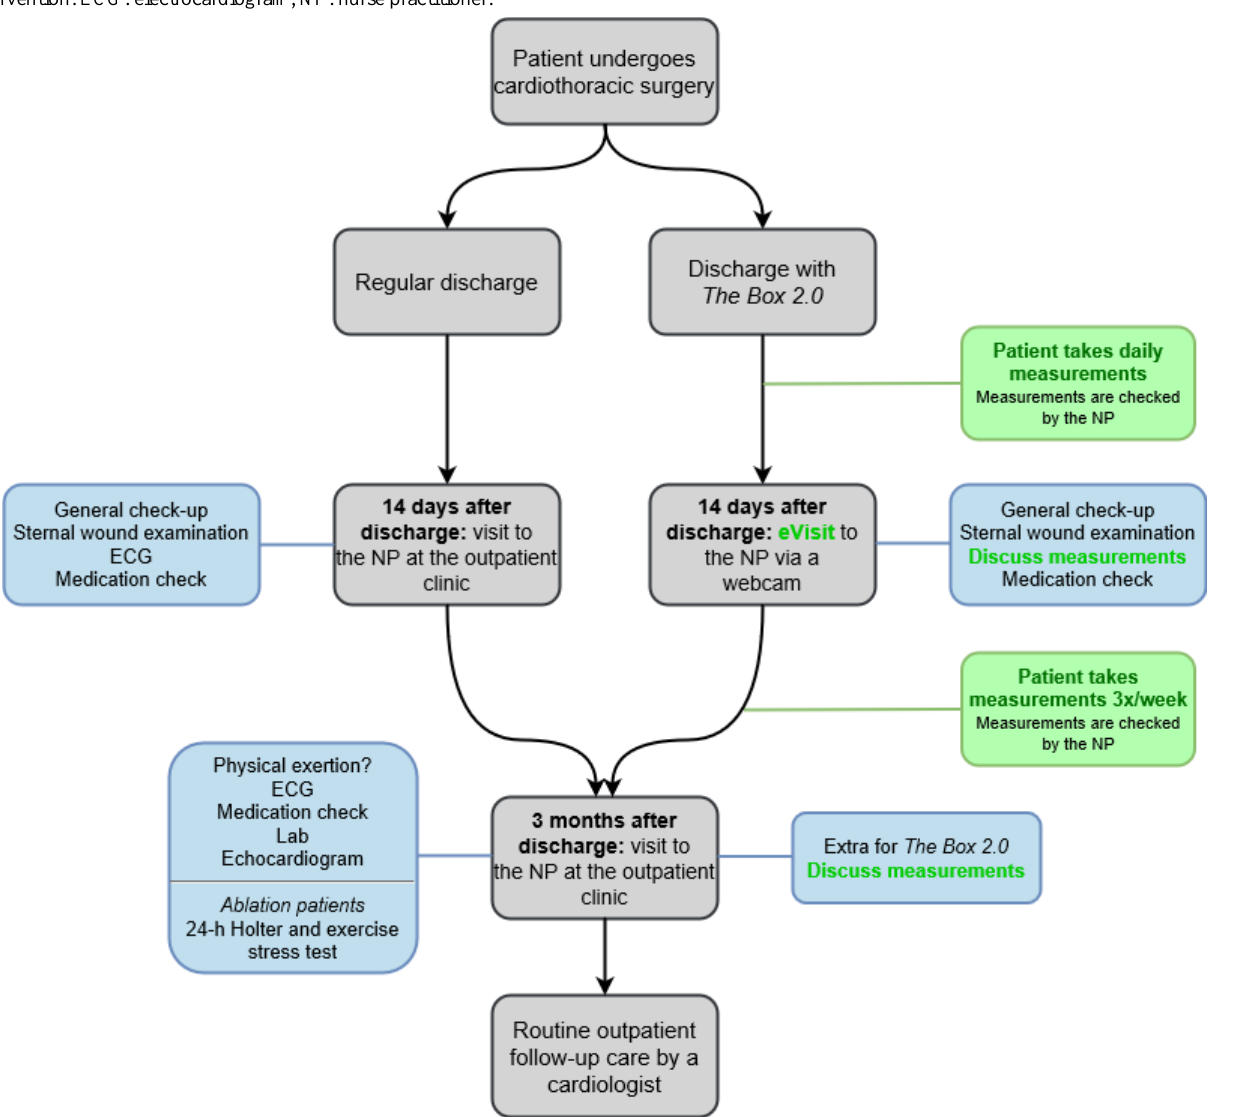
Figure 2. Flowchart for the outpatient clinic follow-up. Left: standard outpatient care without the mHealth intervention. Right: outpatient care with the mHealth intervention. Blue text boxes show the standard topics at 14-day and 3-month consultations. Green text boxes and text highlight the mHealth intervention. ECG: electrocardiogram; NP: nurse